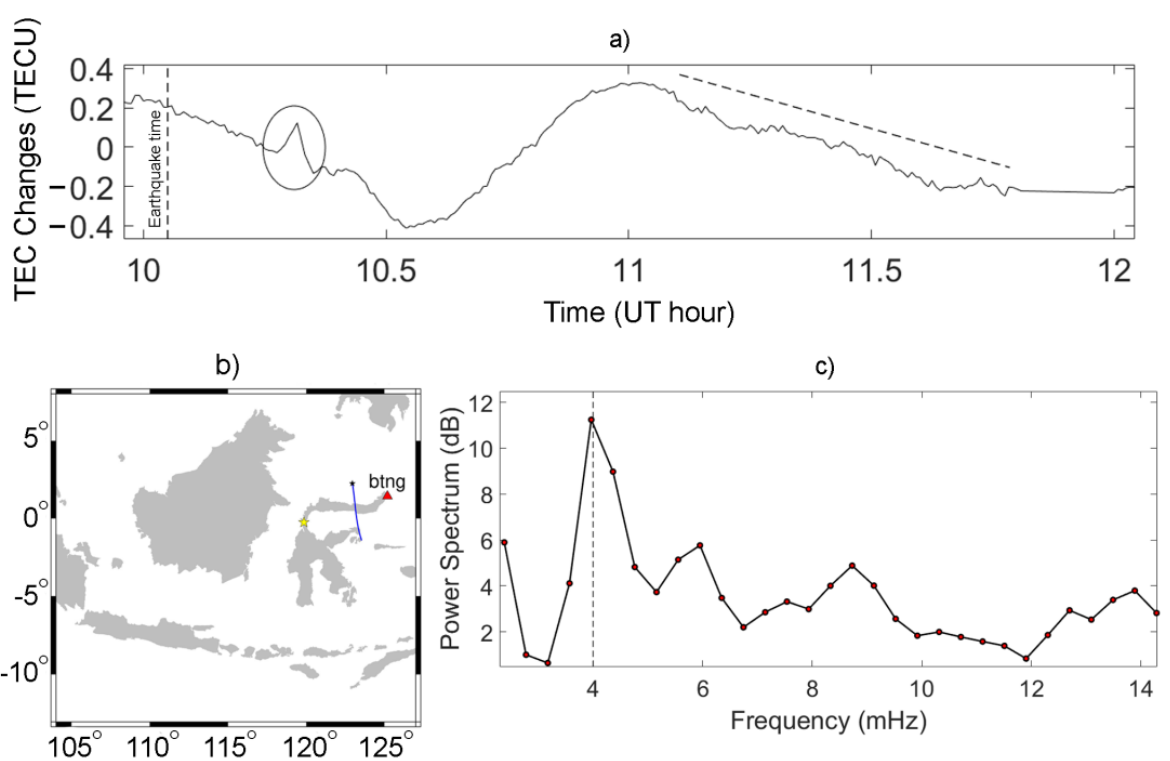
Figure 3. ( a ) The high-pass filtered STEC time-series on BTNG (GPS PRN 21) ( b ) SIPs of the satellites, which was observed from the BTNG station. The spectrogram ( c ) shows a peak around 4 mHz, which is the dominant atmospheric modes that trigger resonant coupling with the solid Earth shown by the dashed line [29]. The vertical, slant, and circle lines in ( a ) represent the time of the earthquake (10:02:45 UT), time windows for the spectral analyses, and CID, respectively. The vertical dashed lines in ( c ) are the frequency peaks at 4